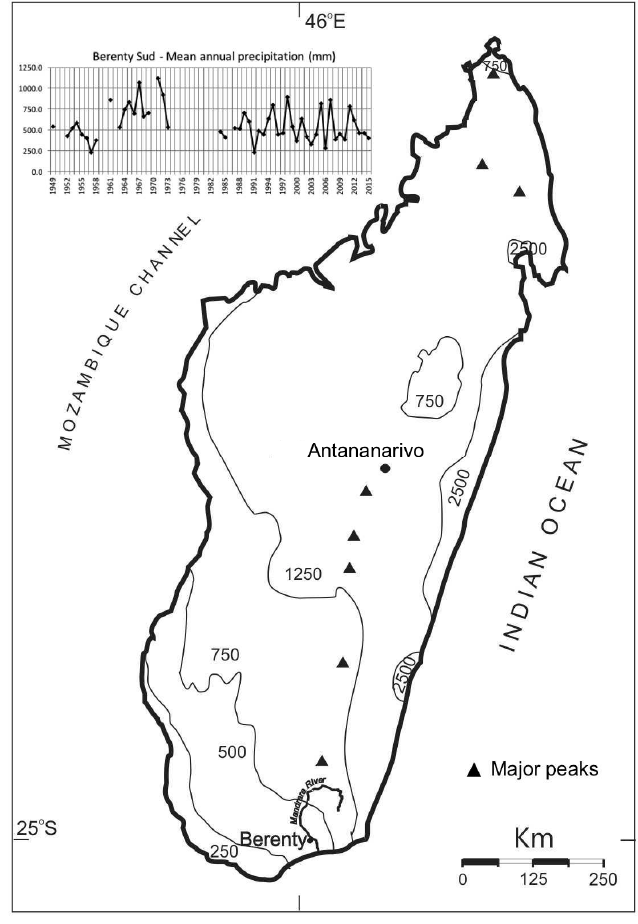
Figure 1. Precipitation map with isohytes (mm), with inset of Berenty precipitation data: note the exceptional flood in 1971. Data courtesy of Mr Rakotomalala, Berenty.